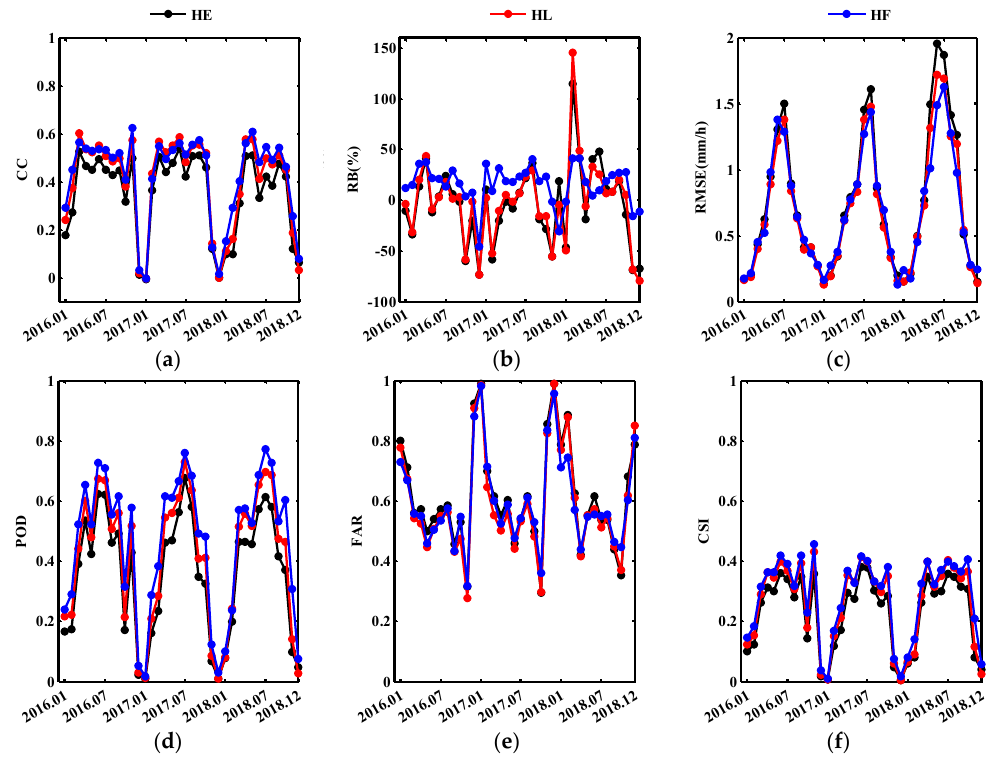
Figure 5. The monthly comparison of the three IMERG hourly products at regional scale from January 2016 to December 2018: ( a ) CC, ( b ) RB, ( c ) RMSE, ( d ) POD, ( e ) FAR, and ( f ) CSI.